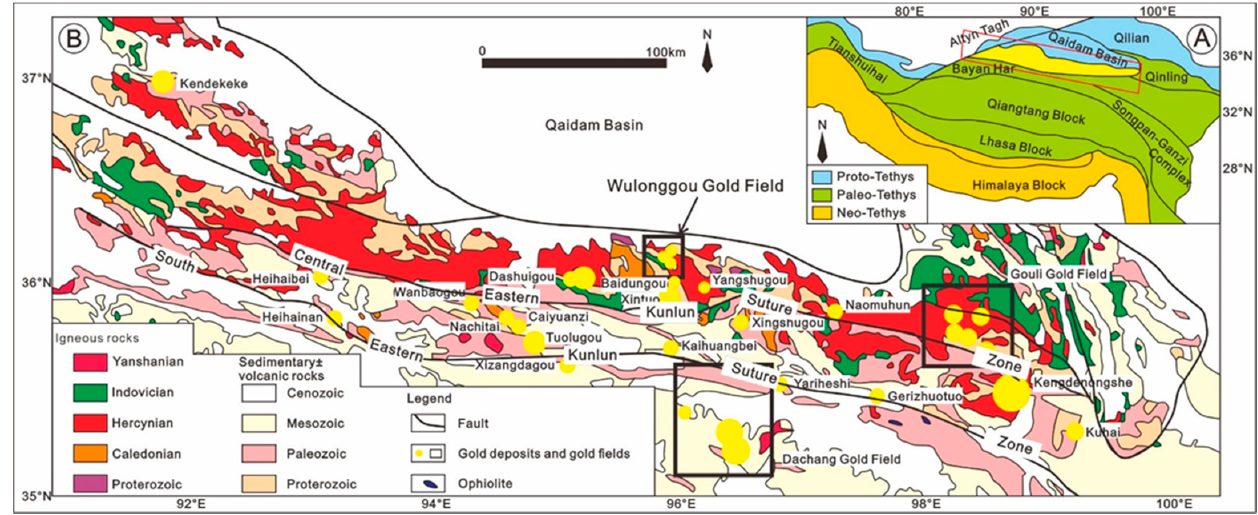
Figure 1. ( A ) The location of the East Kunlun Orogen Belt in the Qinghai–Tibetan plateau (modified after [5]). ( B ) Simplified Geological map of the East Kunlun Orogen Belt (modified after [5]).